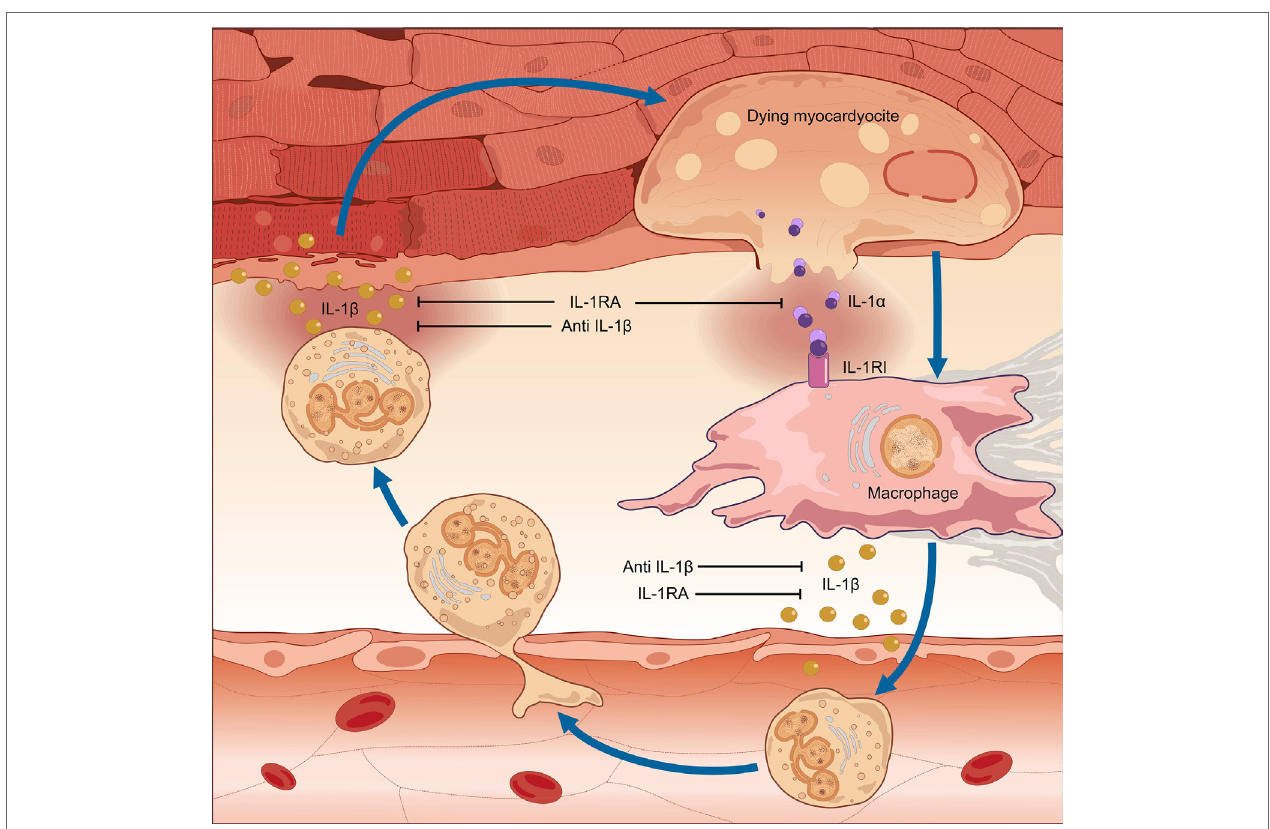
FiGURE 1 | Pathogenesis of myocarditis: the auto-inflammatory hypothesis. In myocarditis, a detrimental inflammatory response leads to cardiac damage, clinically manifested with contractile dysfunction. The pro-inflammatory cytokine interleukin (IL)-1 is of pivotal importance in the pathogenesis of myocardial inflammation. Inflammation of the heart results in myocardial injury. IL-1 α is released from the dying myocardiocytes, together with intracellular debris and inflammatory mediators; these in turn activate a molecular complex known as the “inflammasome,” resulting in processing and release of active IL-1 β by infiltrating inflammatory cells. Runaway cardiac inflammation ensues, leading to apoptosis of cardiomyocytes and loss of contractile tissue, cardiomyopathy, and heart failure. Given the dual efficacy against myocardial inflammation and contractile dysfunction, prompt pharmacologic inhibition of IL-1 can arrest the progression of uncontrolled inflammation, thus preventing extensive tissue damage and arrhythmic complications and restoring cardiac